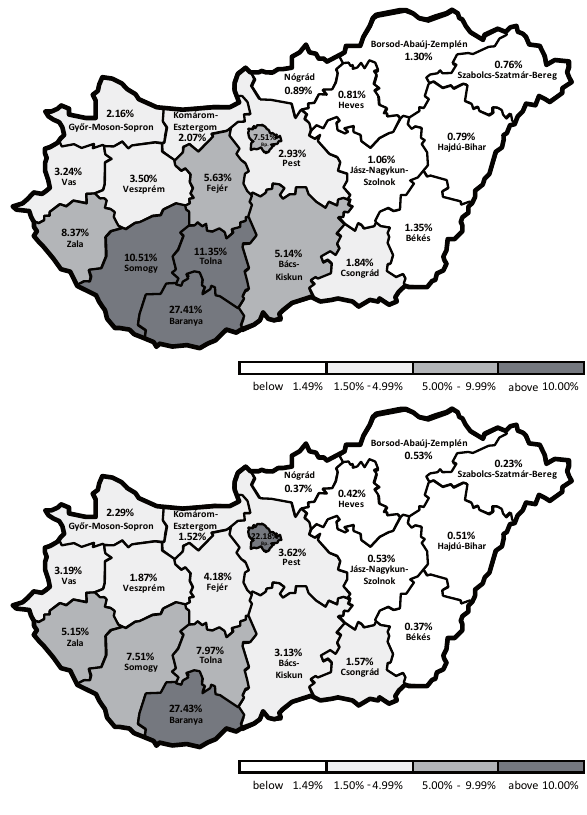
tivities in the counties. However, the major part of the graduates work as employees, of